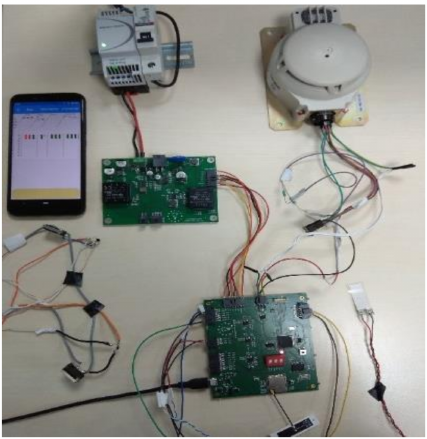
Figure 8. The RMC system set up for laboratory